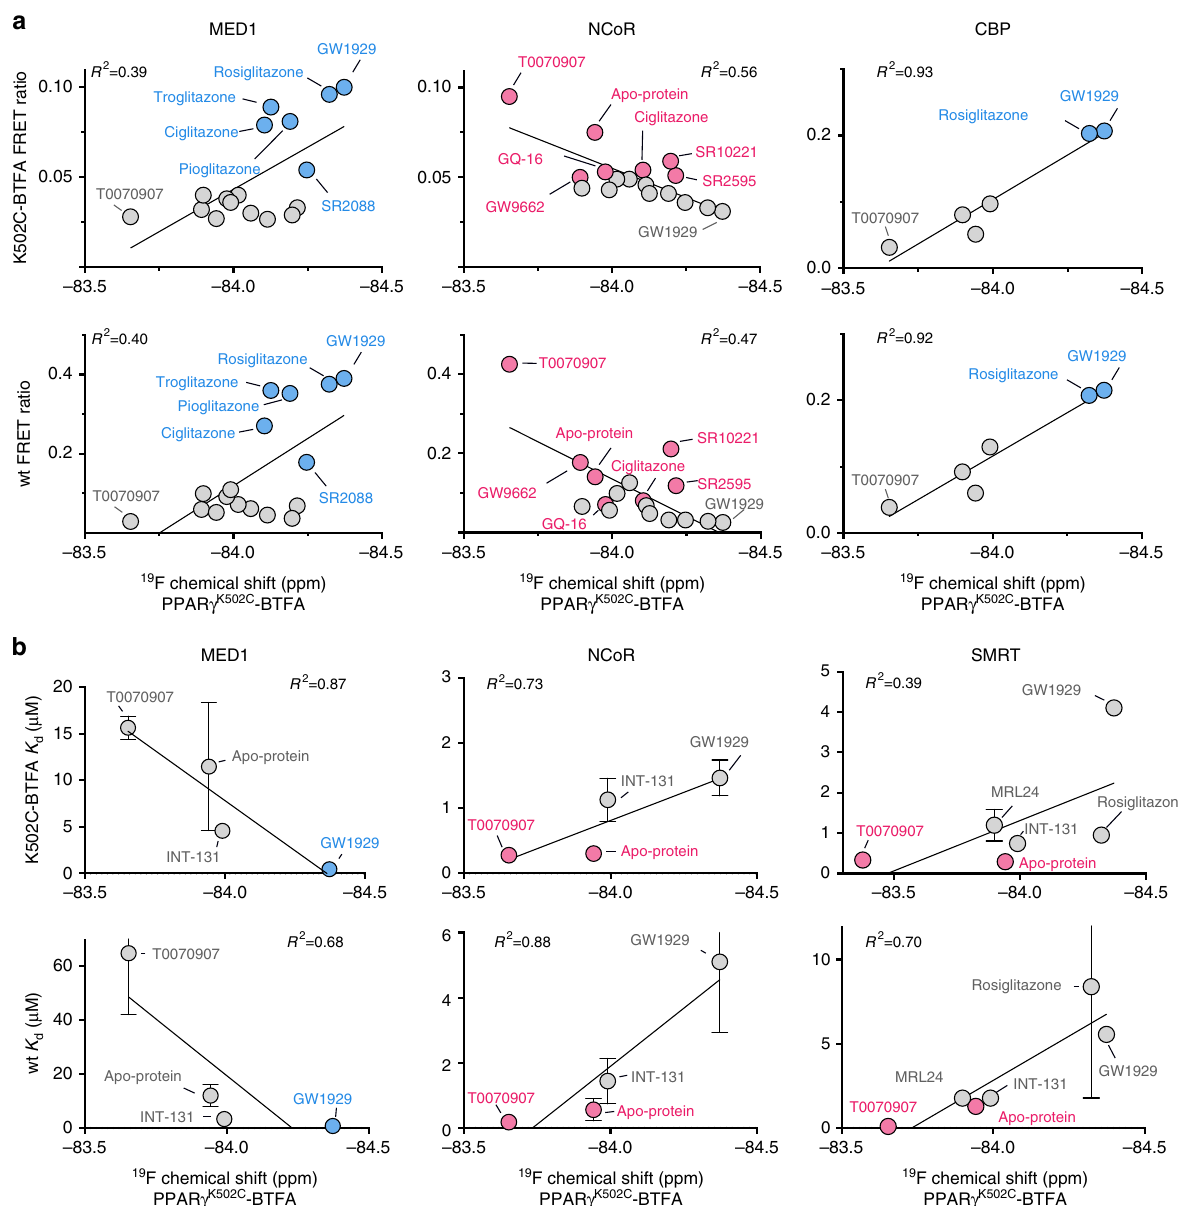
Fig. 6 Ligand-directed helix 12 ensemble dictates PPAR γ – co-regulator interaction. a Plot of mean 19 F NMR chemical shift values (PPAR γ K502C -BTFA) vs. TR-FRET endpoint data for the recruitment of MED1, NCoR, and CBP peptides to PPAR γ K502C -BTFA (top panels) and wt PPAR γ LBD (bottom panels) for the set of 16 pharmacologically distinct synthetic PPAR γ ligands and apoprotein (select ligands for CBP). Error bars are relatively small for endpoint TR- FRET values (Fig. 1 and Supplementary Figure 6) and are excluded for clarity. b Plot of mean 19 F NMR chemical shift values (PPAR γ K502C -BTFA) vs. MED1, NCoR, and SMRT peptide dissociation constant ( K d ) for PPAR γ K502C -BTFA (top panels) and wt PPAR γ LBD (bottom panels) as measured by fl uorescence polarization for a subset of the ligands in a . Linear regression fi t is shown as a solid line and the correlation coef fi cient ( R 2 ) for the fi tted line is indicated. The ligands with the highest ef fi cacy for MED1 and NCoR recruitment for PPAR γ K502C -BTFA are highlighted. Error bars represent standard deviation of two (K502C-BTFA K d and wt SMRT K d ) or three (wt MED1 and NCoR K d ) independent